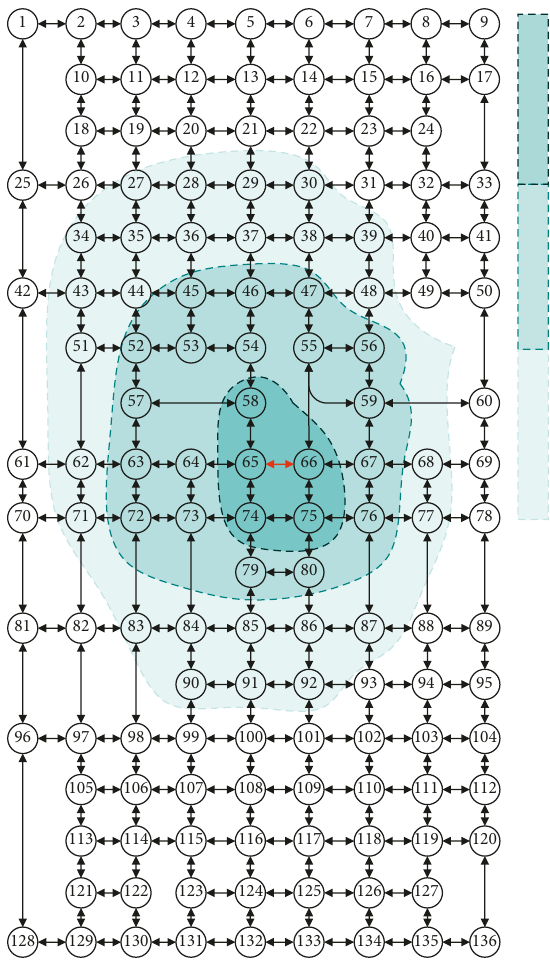
Figure 6: Subnetwork with different thresholds. Figure 7: Subnetwork of field